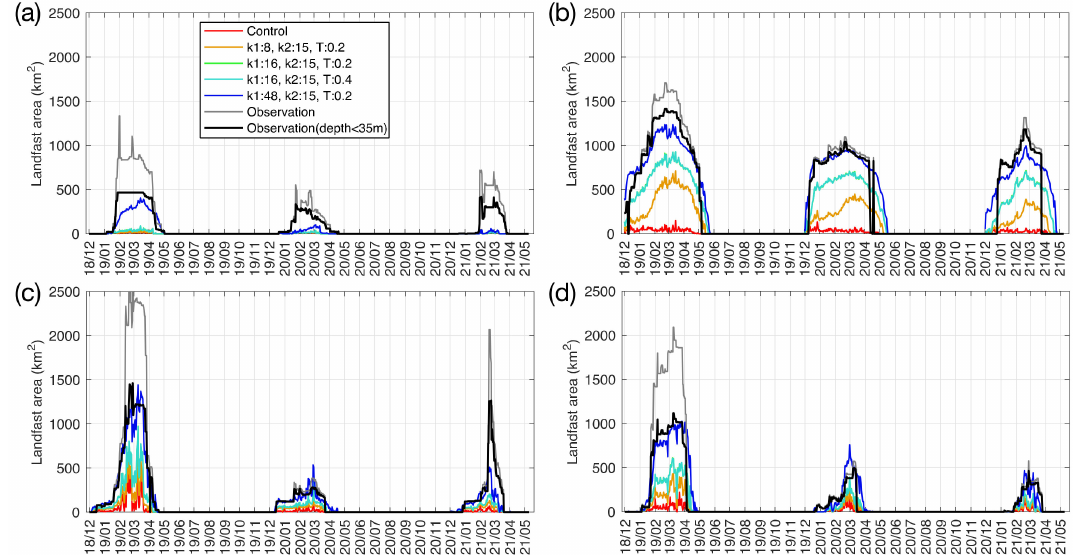
Figure 6. Same as Figure 5 for the time-series of the landfast ice area from model results and NIC observations for of the 4 domains in Figure 4a but with a fixed k 2 value of 15 Nm − 3 , and k 1 varies from 8, 15, and 48, and tensile strength ( T ) varies from 0.2 to 0.4. The panels ( a – d ) correspond to these domains. The gray line indicates the total landfast ice area obtained from NIC observations and the black line indicates the landfast ice area limited to water depths shallower than 35